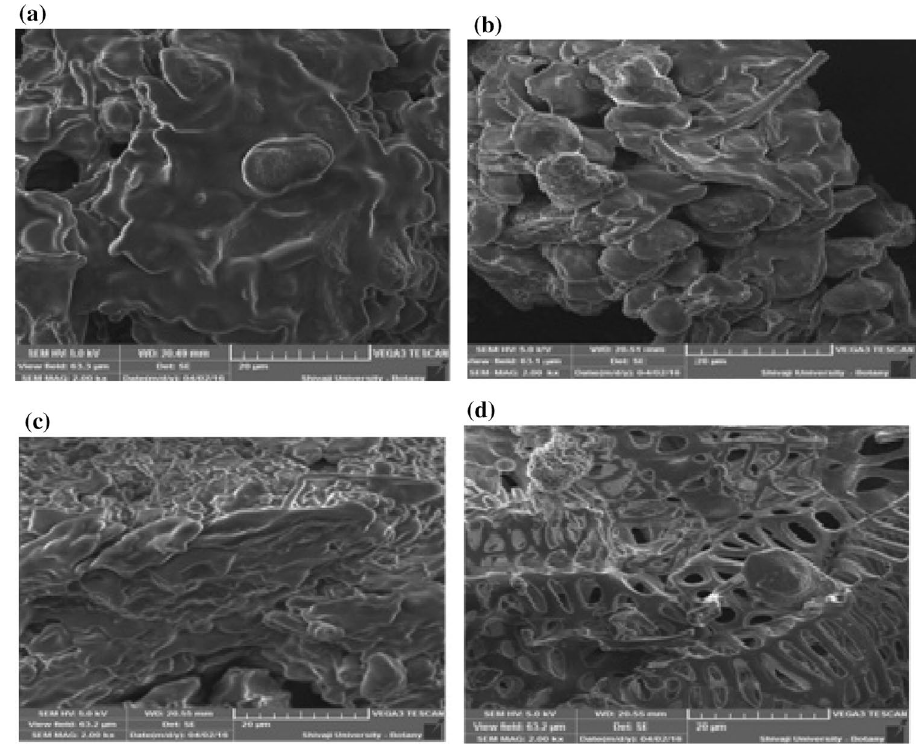
Fig. 2 Results of SEM study for a naturally dried; b sun-dried; c oven-dried; and d